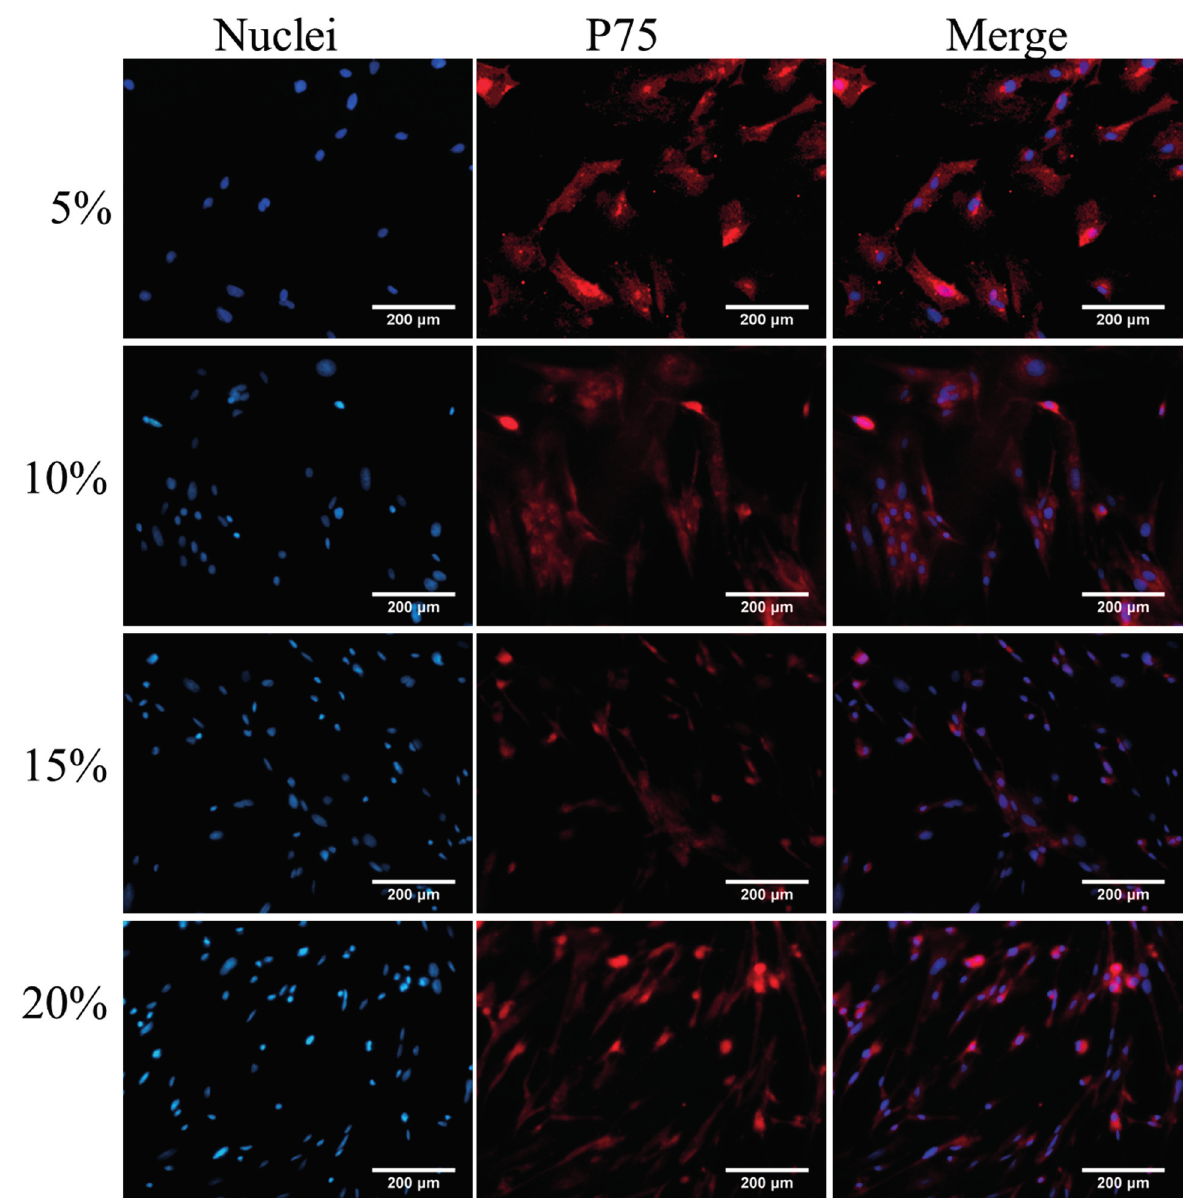
Figure 3. Immunofluorescence staining of OEC first cultured in DF-12 medium containing 10% FBS for 3 days and then cultured in DF-12 medium containing different concentrations (5%, 10%, 15%, 20%) of RS for 4 days. The different concentrations of RS are listed on the left. OEC nuclei stained with DAPI are presented in the left column, P75 of OEC stained with Cy3 are presented in the middle column, and the right column is the merged nuclei and P75. Scale bar is 200 μ